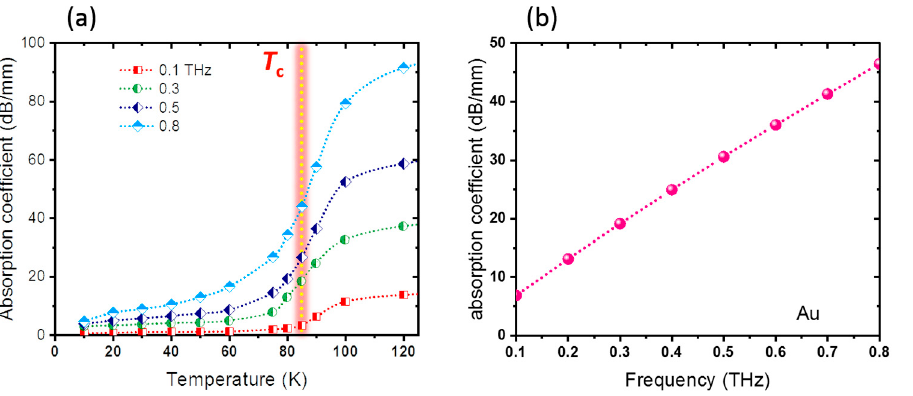
Figure A1. Mode confinement and propagation length of SPPs ( L p ) of BSCCO and gold plasmonic waveguide with structural size of h = 300 nm and w = 300 nm at f = 0.1 THz. The vertical dashed line shows the T c of BSCCO. Modal properties of gold waveguide are not dependent on temperature .